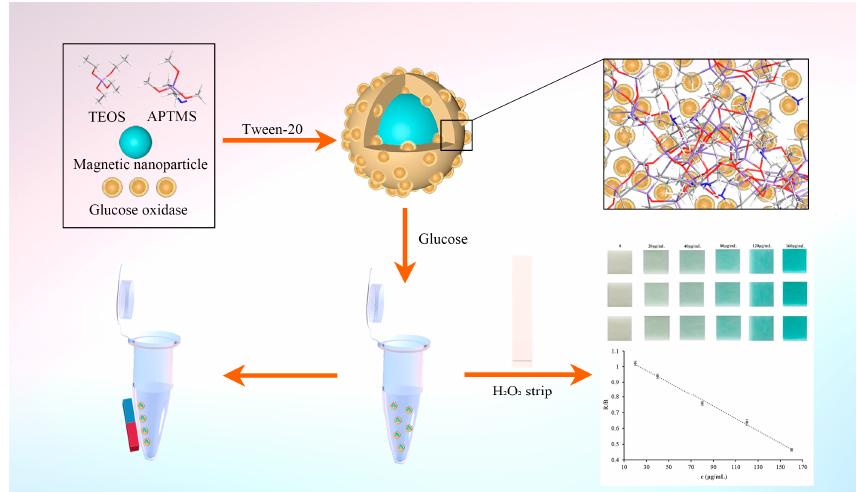
Figure 1. Schematic of preparation and utilization of magnetic embedded enzymes.